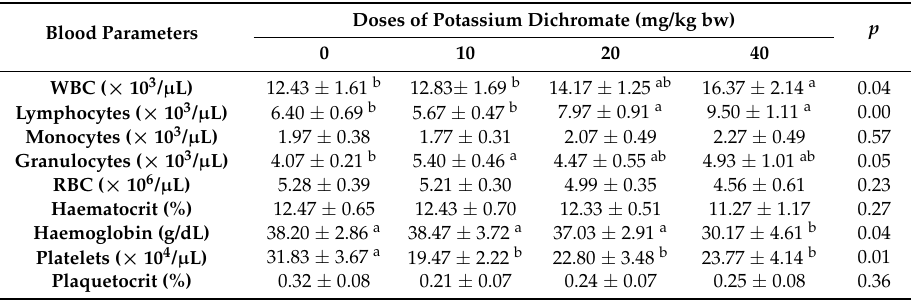
Table 5. Effects of potassium dichromate on hematological parameters in rabbit doe.